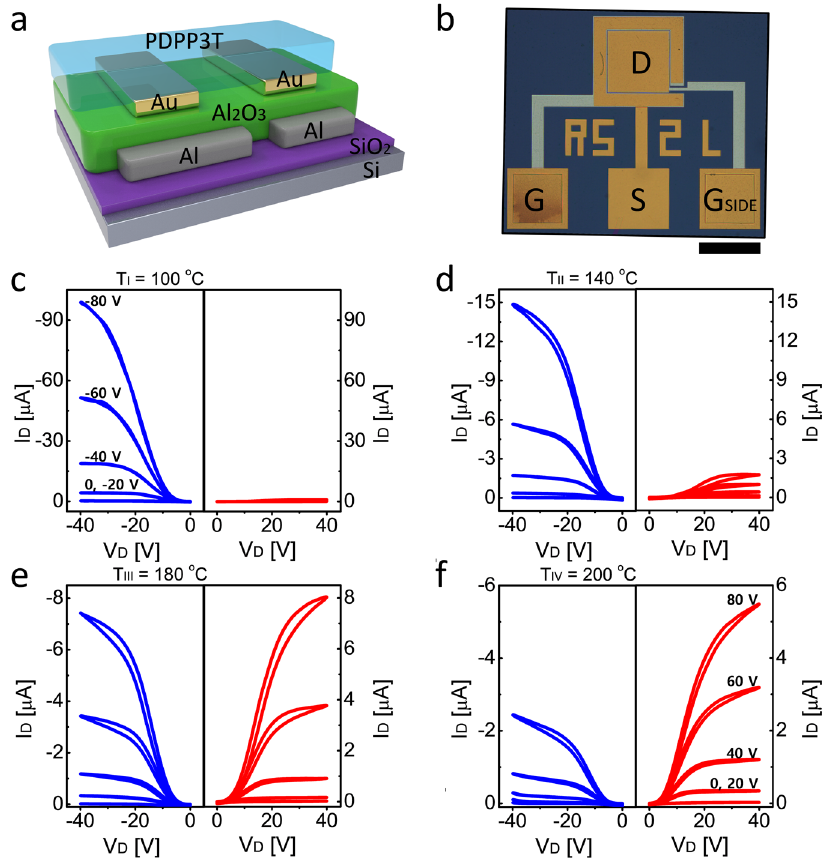
bar is 200 μ m (black). Measured output characteristics at ( c ) T I = 100 °C. ( d ) T II = 140 °C. ( e ) T III = 180 °C. ( f ) T IV = 200 °C. Unipolar p-type operation at V SIDE = − 60 V. Unipolar n-type operation at V SIDE = 60